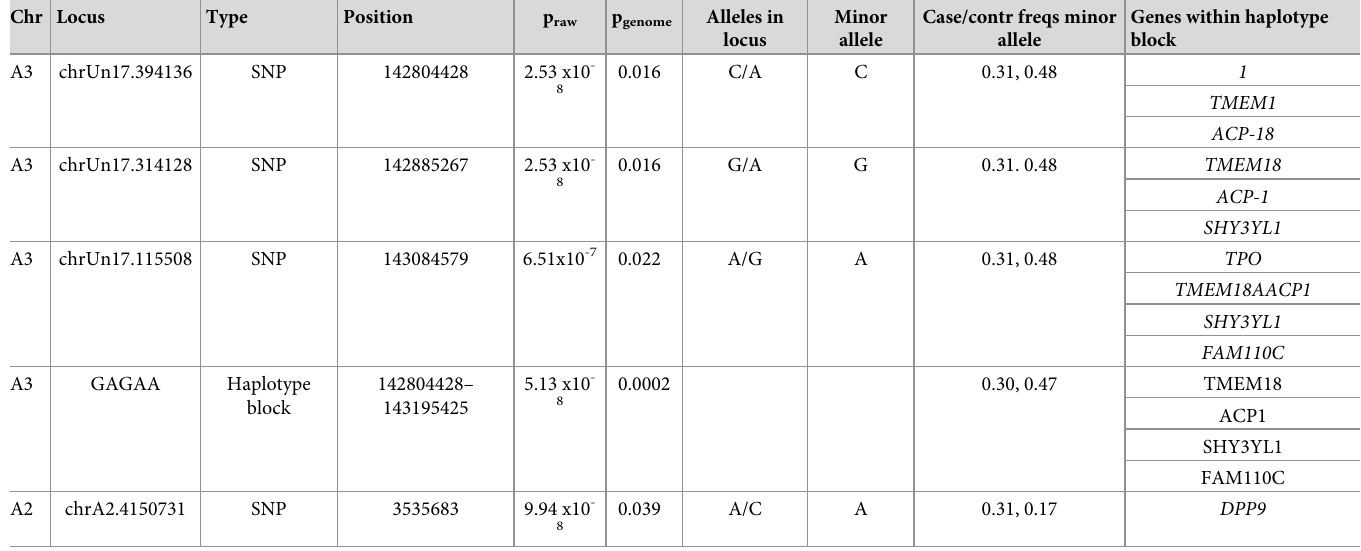
Table 1. Summary of results after association and haplotype